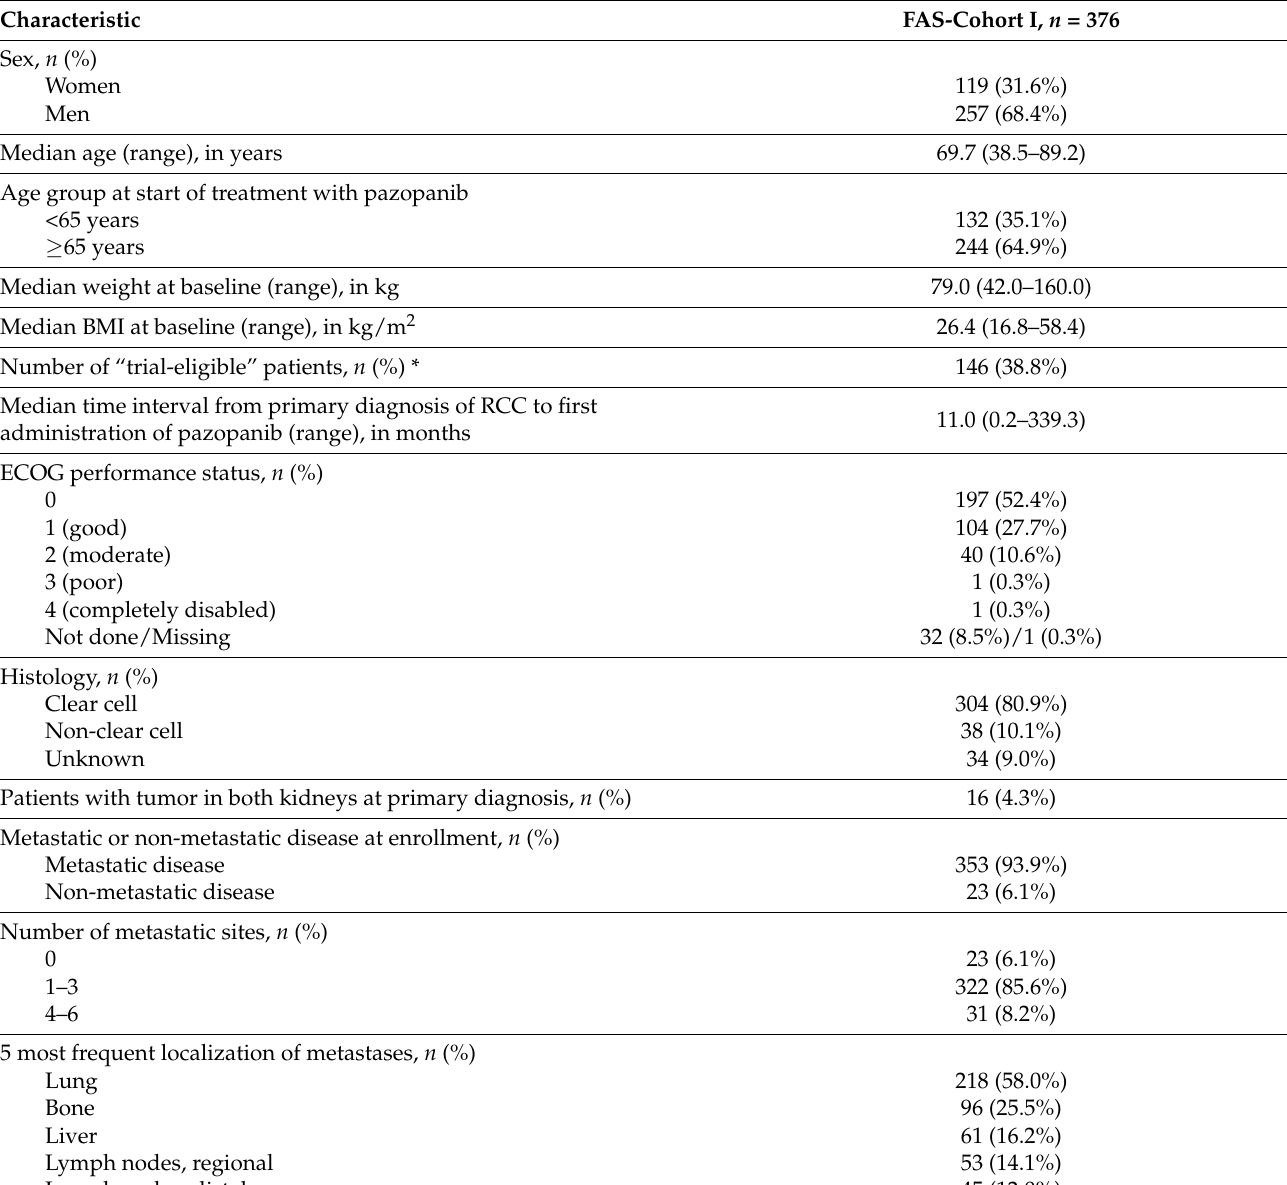
Table 1. Baseline characteristics of FAS-cohort